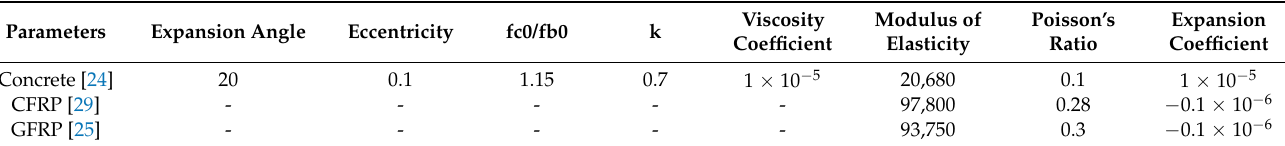
Table 6. Material parameters.